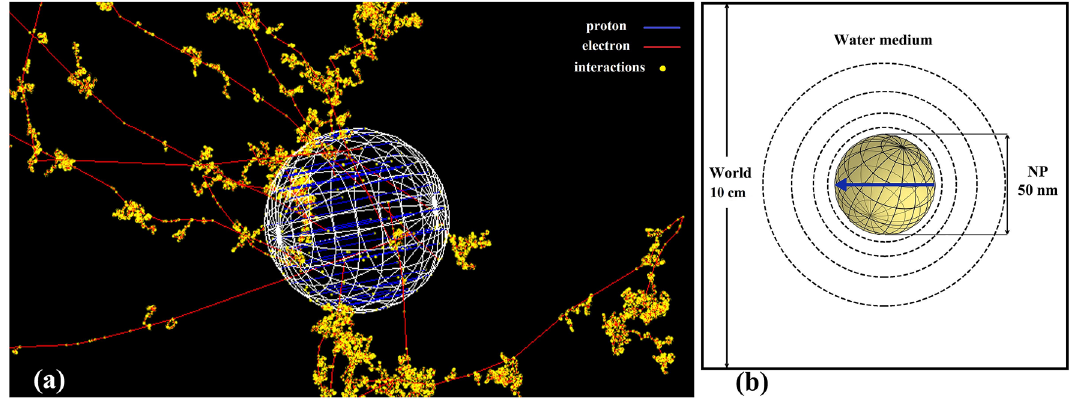
Figure 9. ( a ) Geometry of the Geant4 19 simulation setup. The parallel proton beams (blue) originating and ending inside the GNP and secondary electron (red) tracks through a 50-nm GNP and the surrounding water medium. ( b ) Schematic diagram of the simulation geometry and the scoring spherical shells (mesh) calculating the RDD and DEF around the